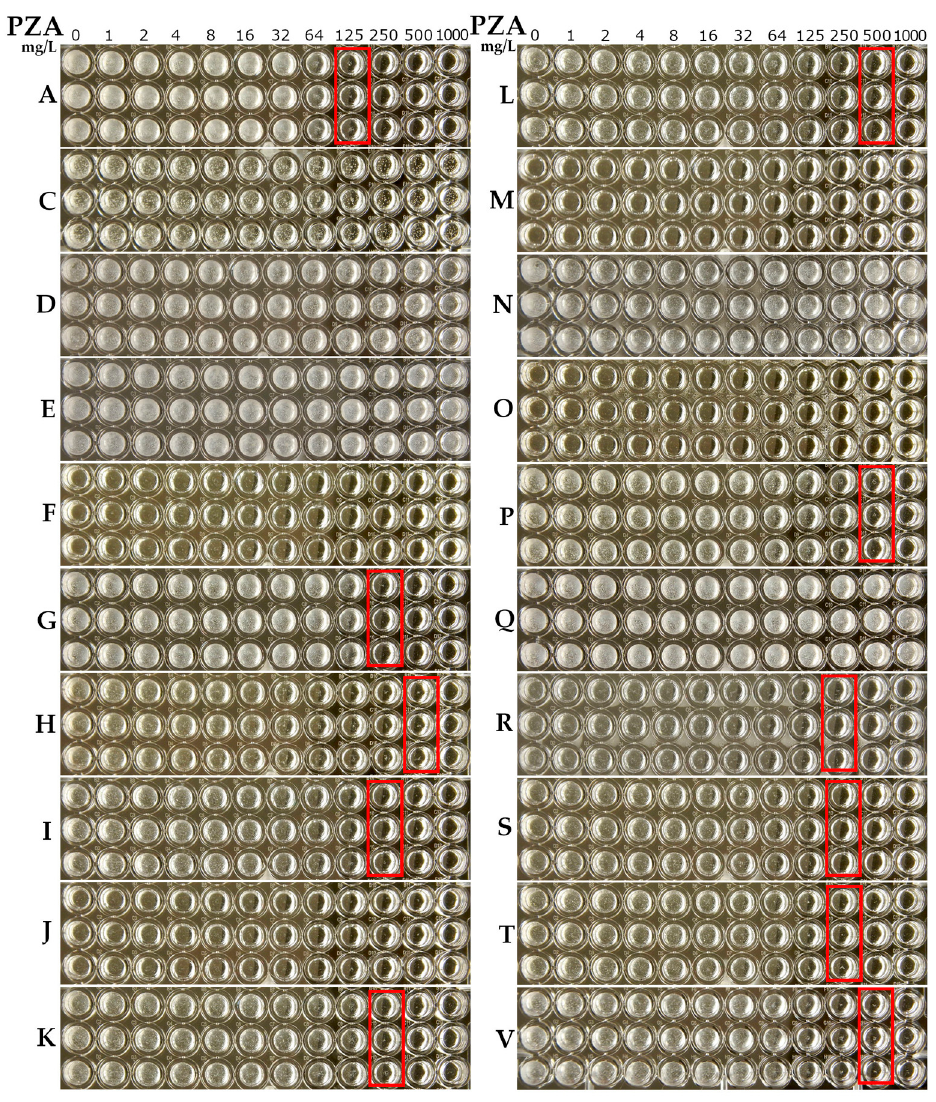
Figure 1 . PZA susceptibility and growth of M. tuberculosis at pH 6.8 using the broth microdilution method in different minimal media and ingredients (described in Table 1) with an amino acid at 2 g/L: the L-Ala result in panel A ; the L-Cys result in panel C ; the L-Asp result in panel D ; the L-Glu result in panel E ; the L-Phe result in panel F ; the Gly result in panel G ; the L-His result in panel H ; the L-Ile result in panel I ; the L-Tyr result in panel J; the L-Lys result in panel K ; the L-Leu result in panel L ; the L-Met result in panel M ; the L-Asn result in panel N ; the L-Trp result in panel O ; the L-Pro result in panel P ; the L-Gln result in panel Q ; the L-Arg result in panel R ; the L-Ser result in panel S ; the L-Thr result in panel T ; the L-Val result in panel V . Red rectangular boxes indicate the lowest PZA concentration wells, which resulted in no visible M. tuberculosis growth. Table 1. MICs of PZA and growth of M. tuberculosis were determined at pH 6.8 in different minimal media at 37 °C for 20 days with the microdilution broth method.